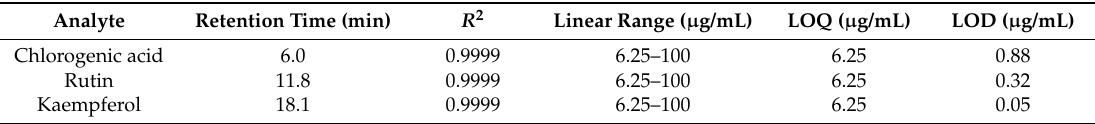
Table 2. High-performance liquid chromatography (HPLC) data for the calibration graphs and limit of quantification (LOQ) of the three active compounds.